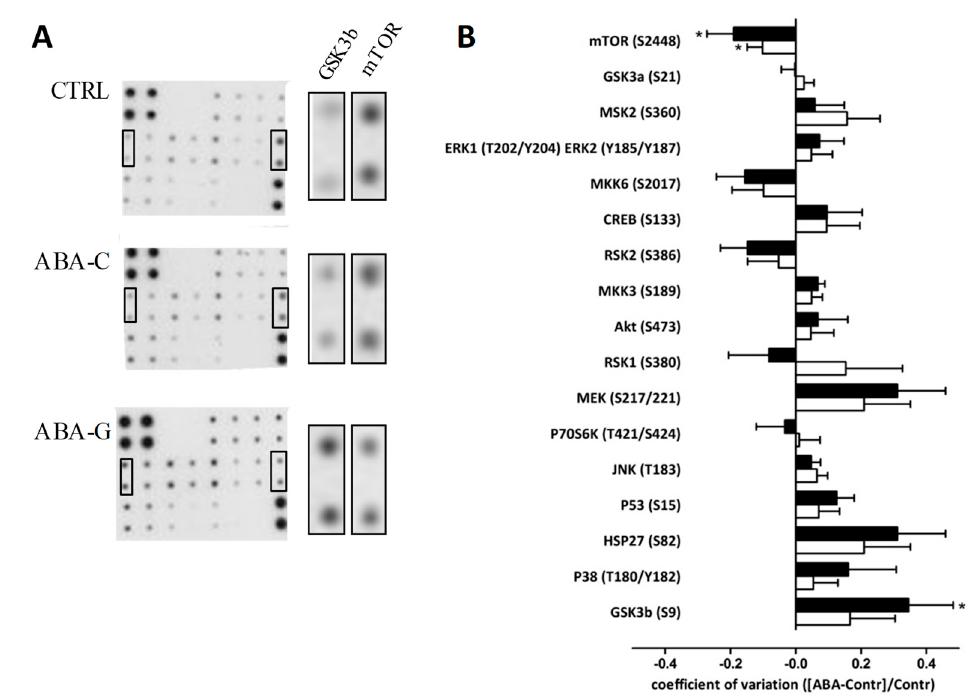
Figure 7. Colonic phosphorylation levels of proteins involved in signaling pathways. Phosphorylation levels of 17 proteins involved in the signaling pathway were evaluated by the MAPK array kit. Representative membranes are shown ( A ) for each group: CTRL, ABA-C and ABA-G, ( n = 8 / group). Horizontal graph bar columns ( B ) show di ff erential ratio levels in ABA-C (open bars) and ABA-G (black bars) compared to control mice. *: p < 0.05 vs. CTRL.